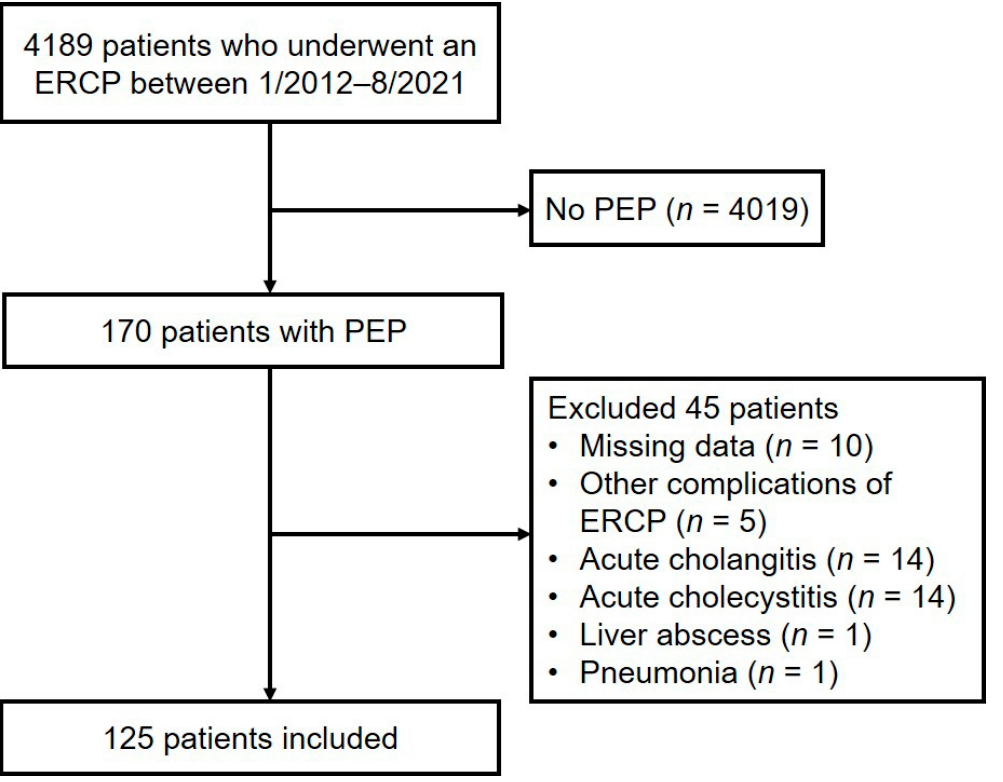
Figure 1. Flowchart of patient enrollment. ERCP, endoscopic retrograde cholangiopancreatography; PEP, post-ERCP pancreatitis.